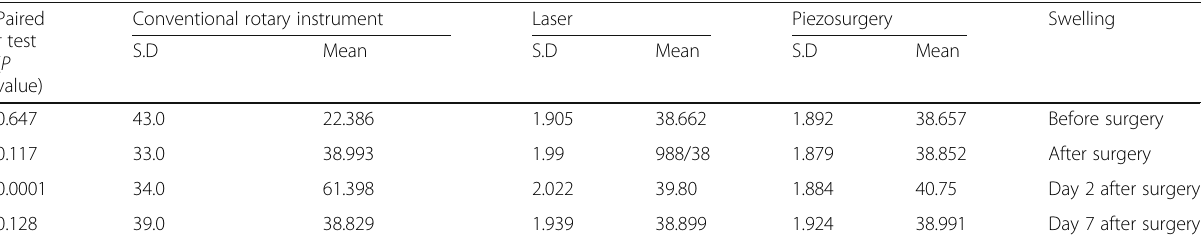
Table 2 Comparison of facial dimension variable to investigate the swelling in the three surgical techniques Paired t test ( P